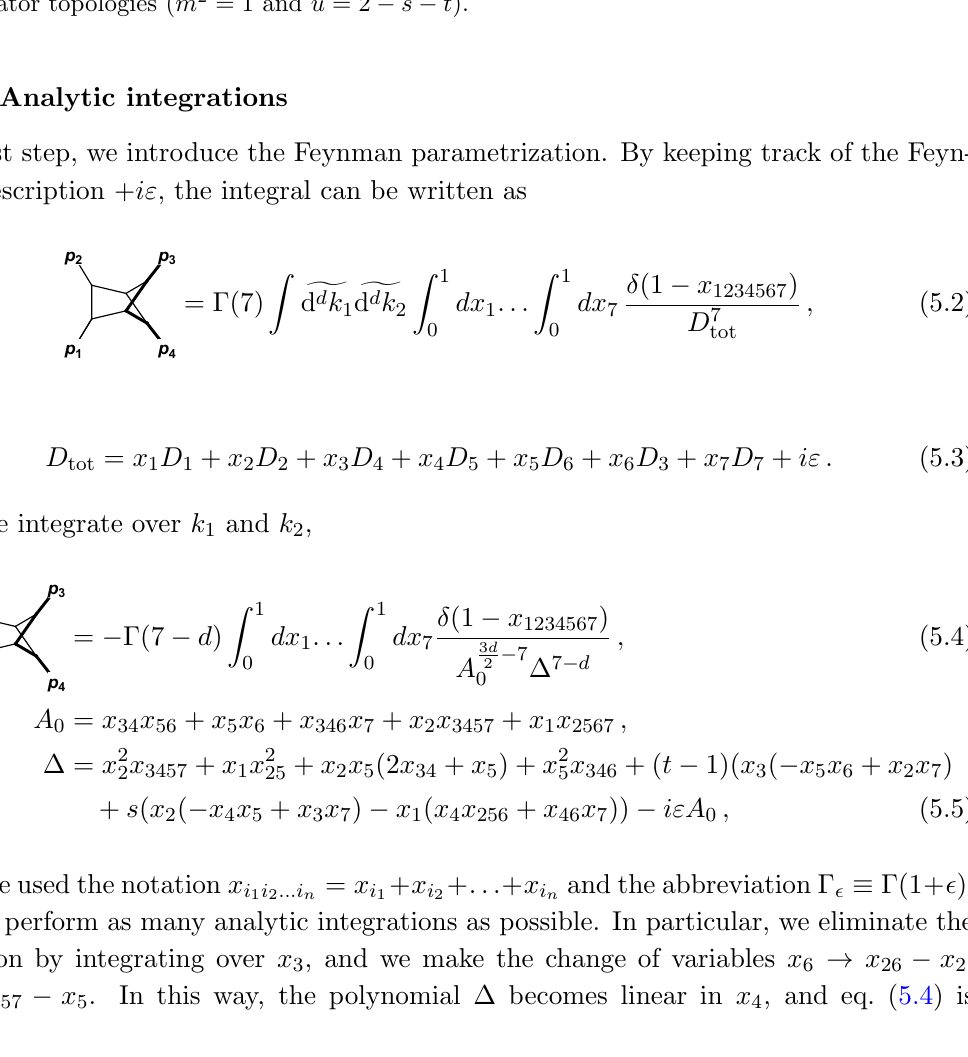
Numerical results for our set of quasi-(cid:12)nite non-planar MIs belonging to the 7- denominator topologies ( m 2 = 1 and u = 2 (cid:0) s (cid:0) t